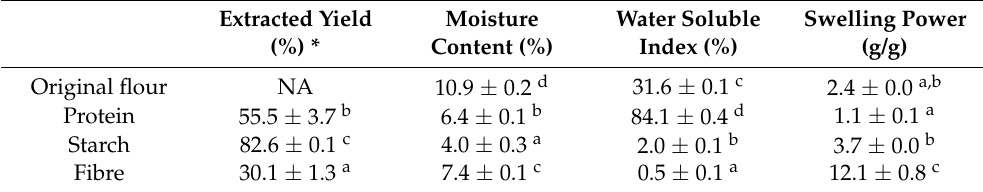
Table 2. Properties of faba bean cotyledon flour and isolated fractions; starch, protein and fibre. Extracted Yield Moisture Water Soluble (%) * Content (%) Index (%) (g/g) Original